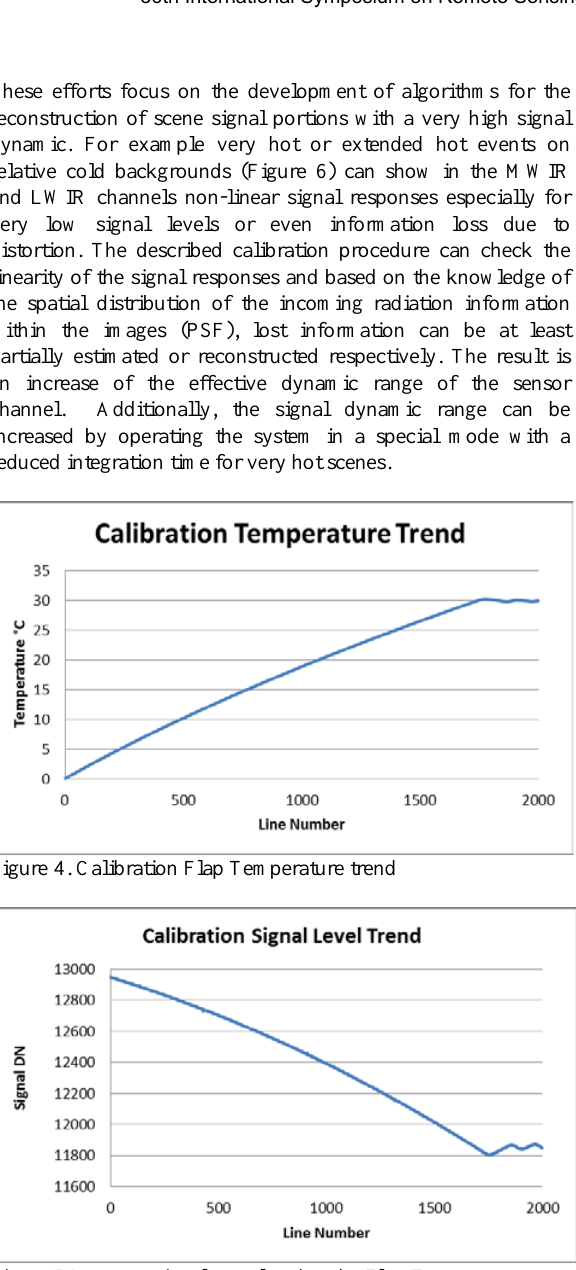
Figure 5 Detector signal correlated to the Flap Temperature